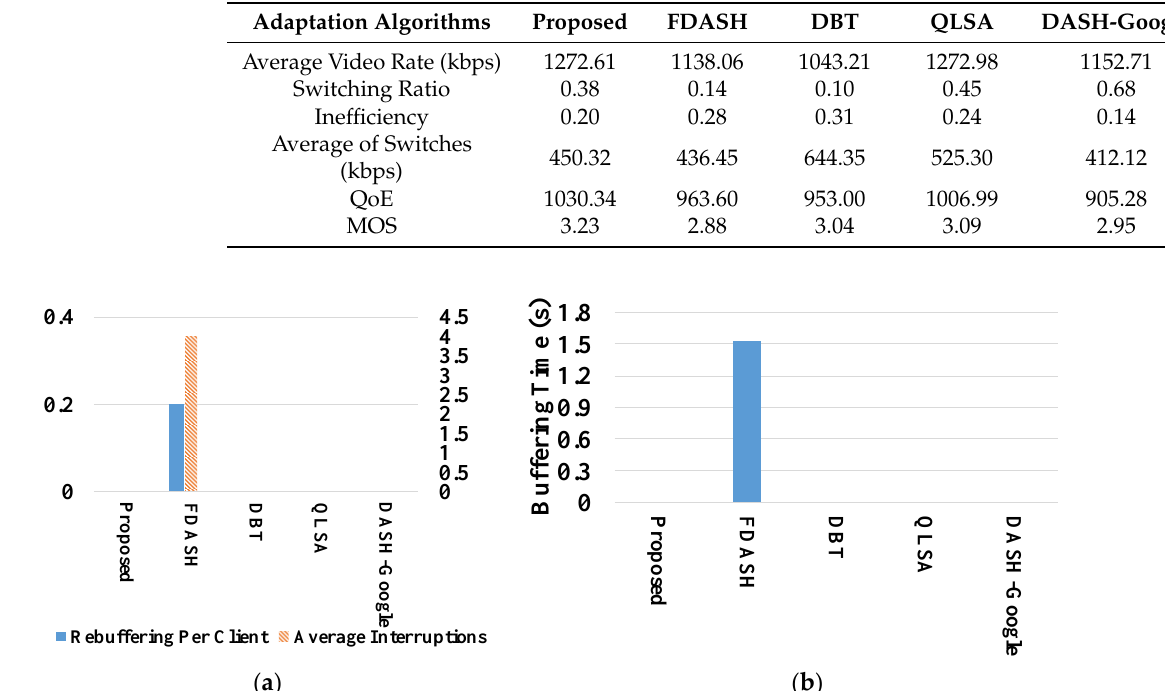
Figure 11. Comparison of ( a ) rebufferings per client and average number of interruptions, and ( b ) average buffering time when the clients downloaded Dataset 1. The buffer size and segment duration were set to 60 s and 4 s, respectively.